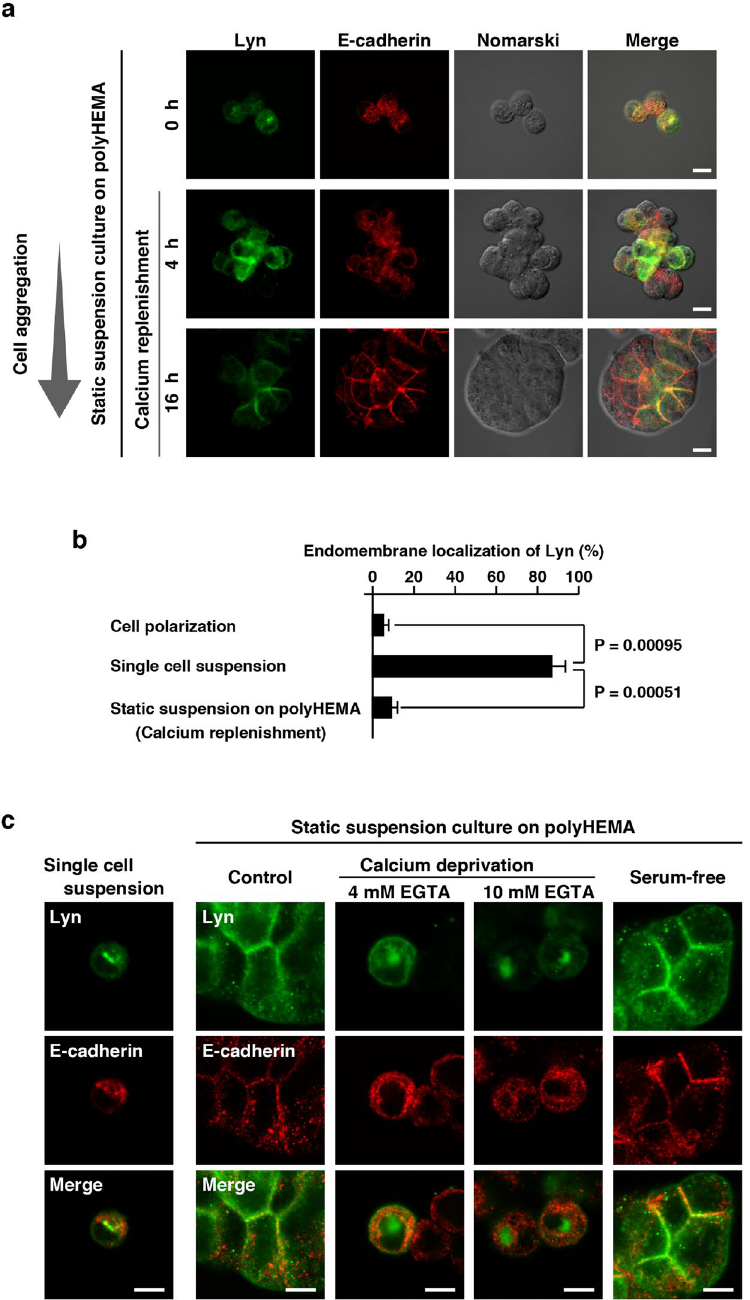
Figure 7. Relocation of Lyn to the plasma membrane by cell-cell interactions. (a , c) Cells cultured as described below were stained with rabbit anti-Lyn and anti-E-cadherin antibodies. Scale bars, 10 μ m. (a) MDCK/TR/Lyn cells cultured as confluent monolayers (polarized cells) were treated with 1 μ g/ml Dox for 8 h, detached by trypsinization and subsequently cultured in a spinner flask with calcium- and serum-free IMDM (single cell suspension culture). Single suspended cells were transferred into polyHEMA-coated culture dishes and cultured in IMDM-5% bovine serum (calcium replenishment) for the indicated time (static suspension culture). (b) Single suspended cells cultured as described in (a) (single cell suspension culture) were transferred into polyHEMA-coated culture dishes and cultured in IMDM-5% bovine serum (calcium replenishment and static suspension culture) for 20 h. Cells were stained with anti-Lyn antibody and propidium iodide. The number of cells exhibiting predominant accumulation of Lyn to endomembranes was counted. The data represent the mean ratio ± S.D. from three independent experiments in which at least 50 cells for each category were scored. The significant differences are calculated by one-tailed Student’s t test. (c) Cells cultured as described in (a) (single cell suspension culture) were transferred into polyHEMA-coated culture dishes and cultured for 16 h in IMDM containing 5% bovine serum (static suspension culture, Control), IMDM containing 5% bovine serum in the presence of 4 mM or 10 mM EGTA (static suspension culture, Calcium deprivation), or serum-free IMDM (static suspension culture, Serum-free). Scale bars, 10 μ